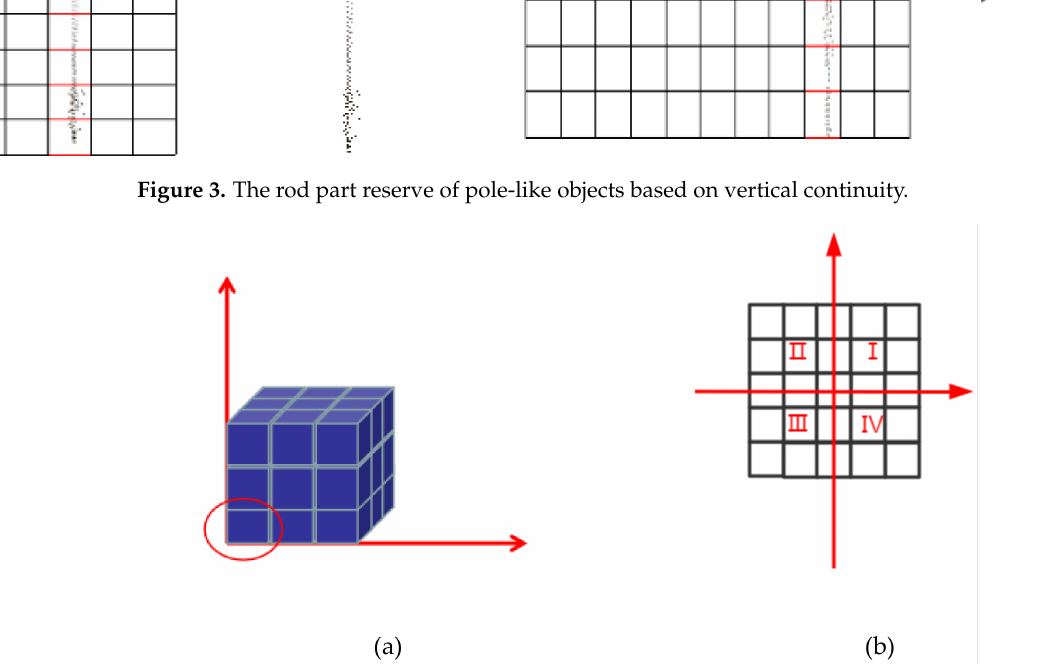
Figure 4. ( a ) The initial voxel based on the regional growth of the voxel; ( b ) coordinate system division of regional growth based on the voxel.